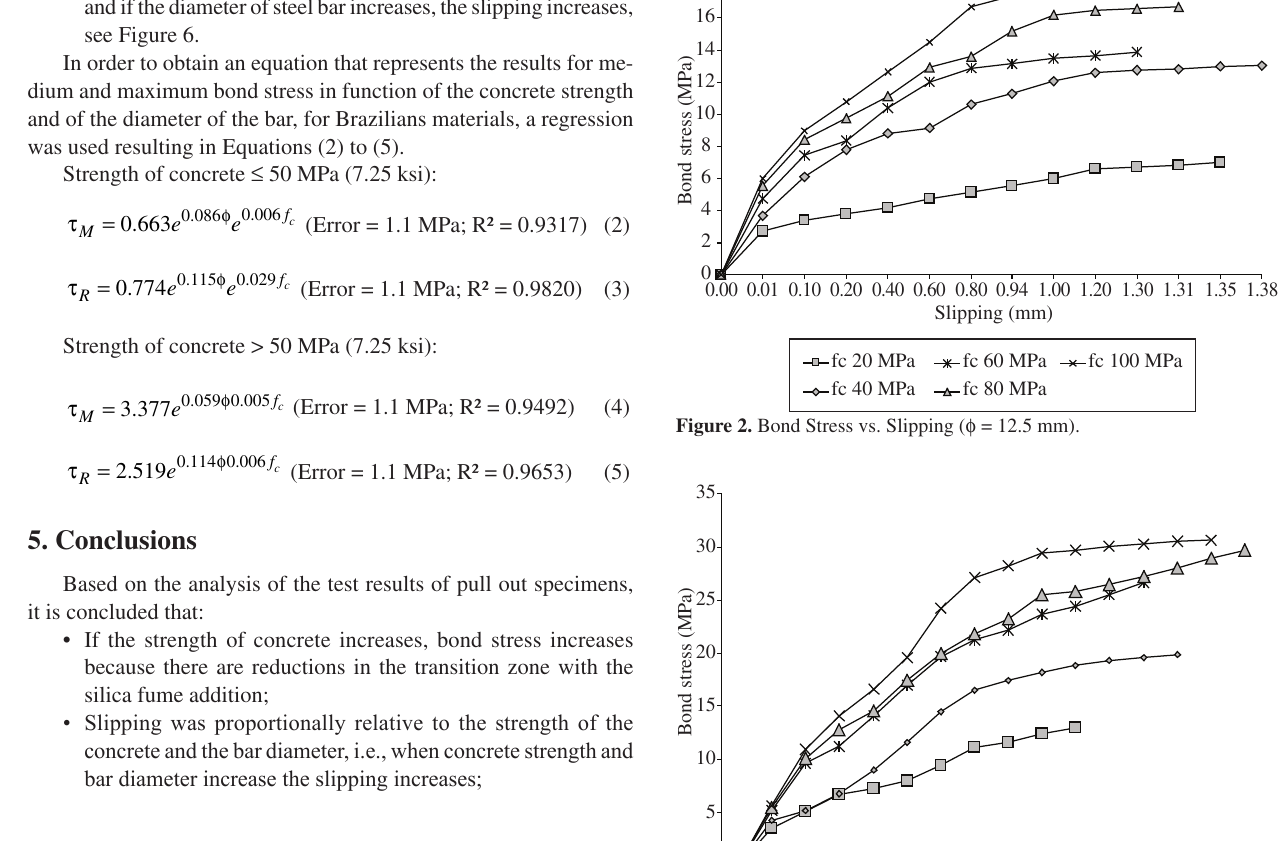
Table 3. Characterization of steel bars.